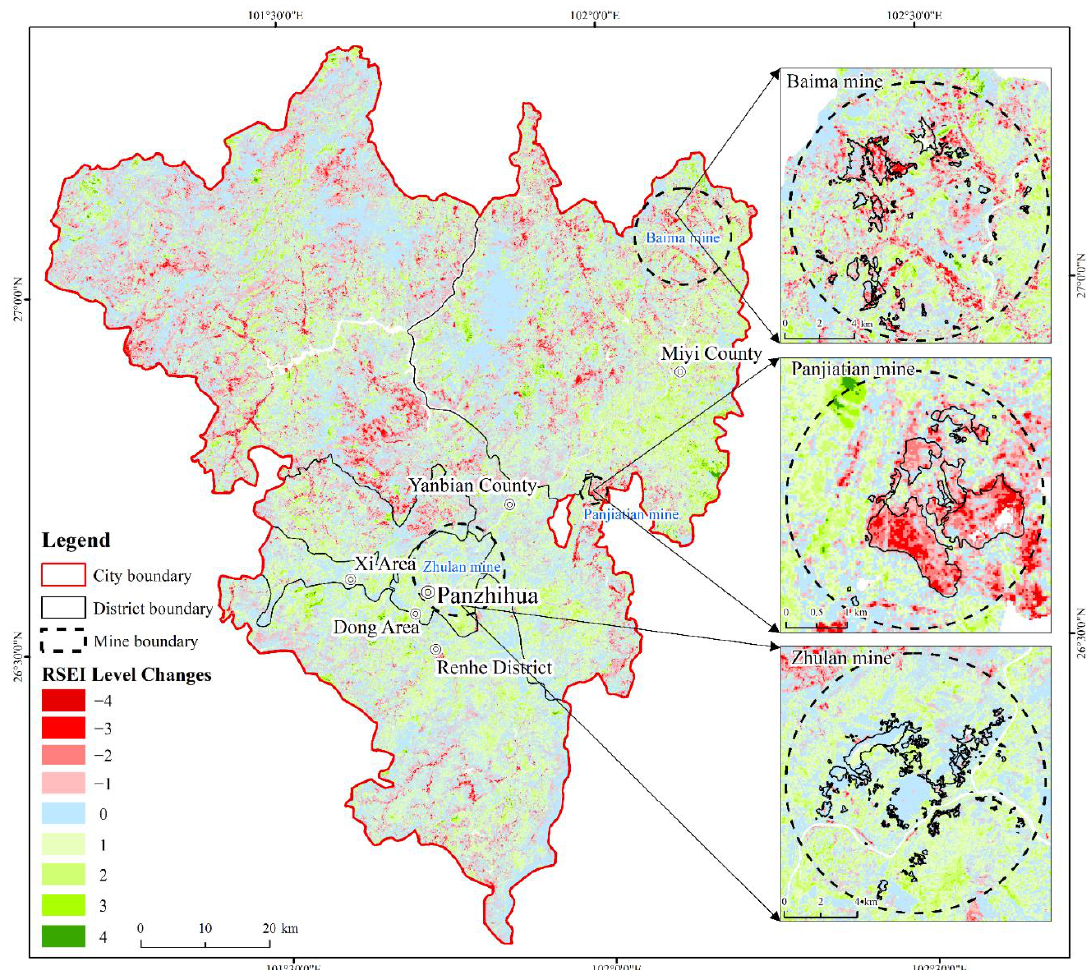
Figure 8. RSEI Detection Change in Panzhihua from 1990 to 2020. Table 3. Detection of Changes in RSEI Levels 1990 – 2020.